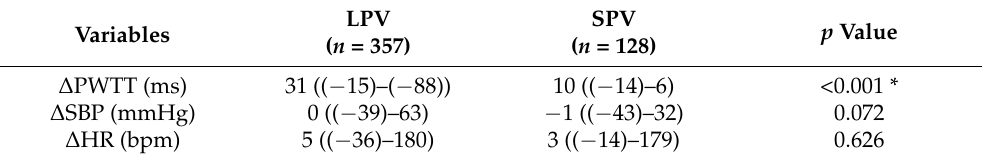
Table 2. Mann–Whitney test of LPV toward ∆ SBP and ∆